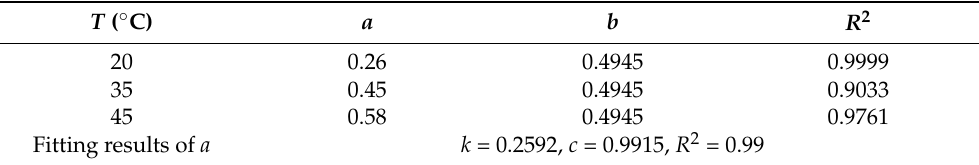
Table 2. Fitting results of the rut depth prediction model coefficients, based on the asphalt mixture flow number test data.